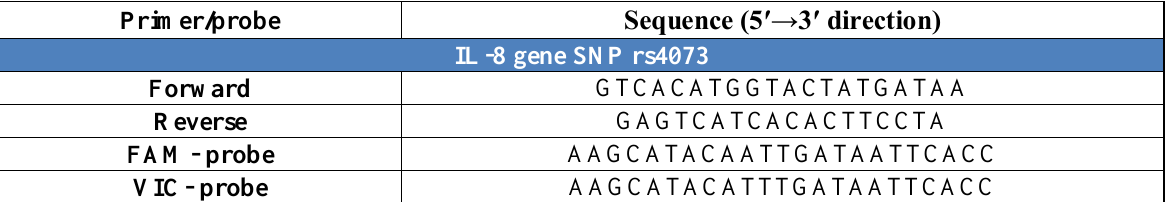
Table 1 : Primers and Probes.